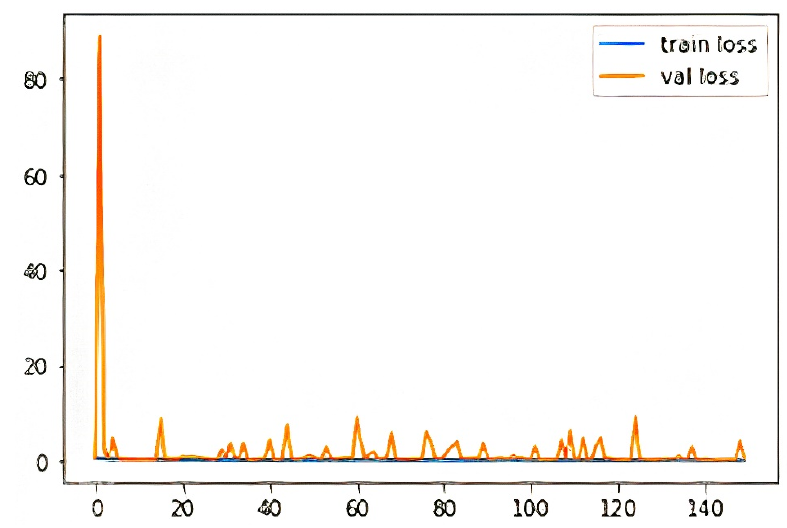
Figure 21. Training and validation loss for the best performing Xception model. (train loss: training loss, val acc: validation loss).